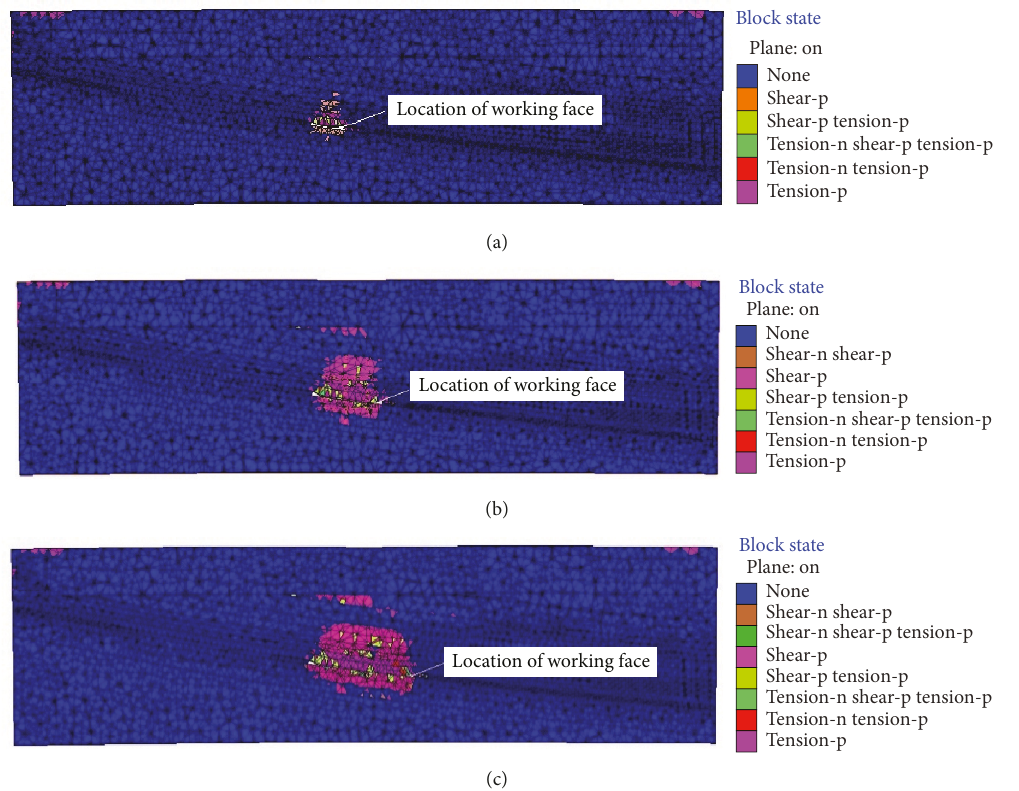
Figure 5: Distribution of plastic deformation of the overlying strata at di ff erent mining distances: (a) working face mined to 50 m, (b) working face mined to 100 m, and (c) working face mined to 150 overlying strata after excavating 200 m are shown in Figure 6. From the simulation results of di ff erent mining upper limits, the displacement vector map and contour of displacement of each mining upper limit are similar in shape with consistent stratal movement. After mining, stress is concentrated at the edge of the gob and shear fail- ure occurs in the rock mass above the coal pillar. Accord- ing to the distribution of the maximum and minimum principal stresses, the coal seam roof area is a destressed zone, where stress is redistributed after the coal seam is mined. The rock mass is dominated by tensile failure. On the upper gob, tensile failure, tensile shear failure, and shear failure zones develop successively from the bottom to the top. As the mining area increases, the range of the maximum principal stress contour constantly expands, the shape and height constantly change, and the plastic failure zone of the strata continues to develop forward and upward, indicating that the caving zone and the WFFZ are increasing continuously.